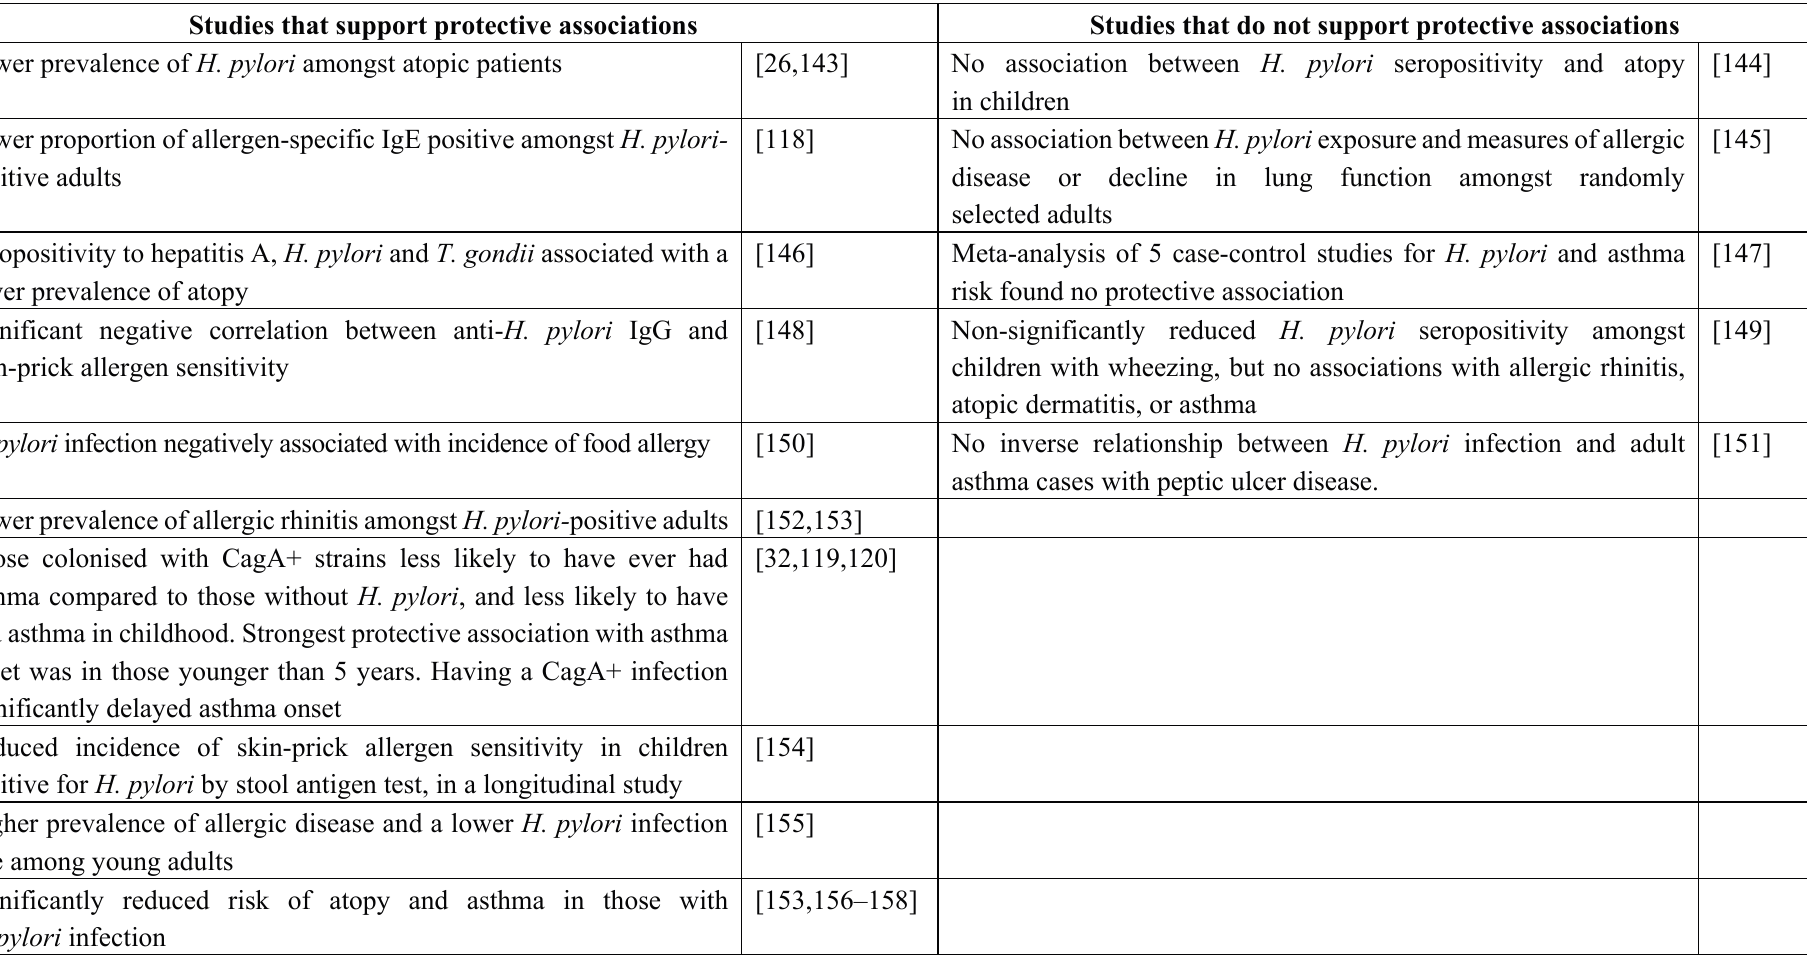
Table 1. Epidemiological evidence for and against H. pylori- mediated protection against allergy and asthma. Studies that support protective